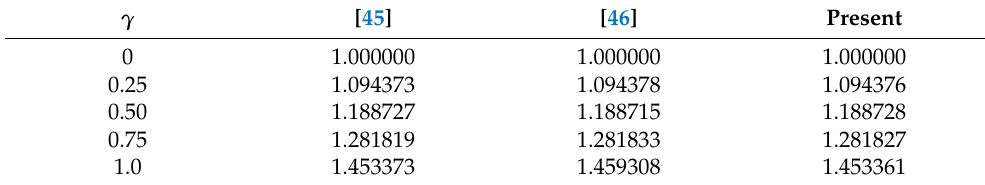
Table 1. A comparison of skin friction − Re 1/2 C f